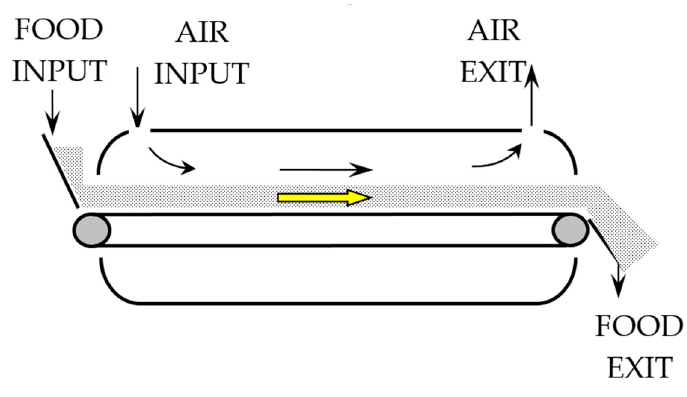
Figure 1. Conveyor belt dryer with tangential flow in co-current.